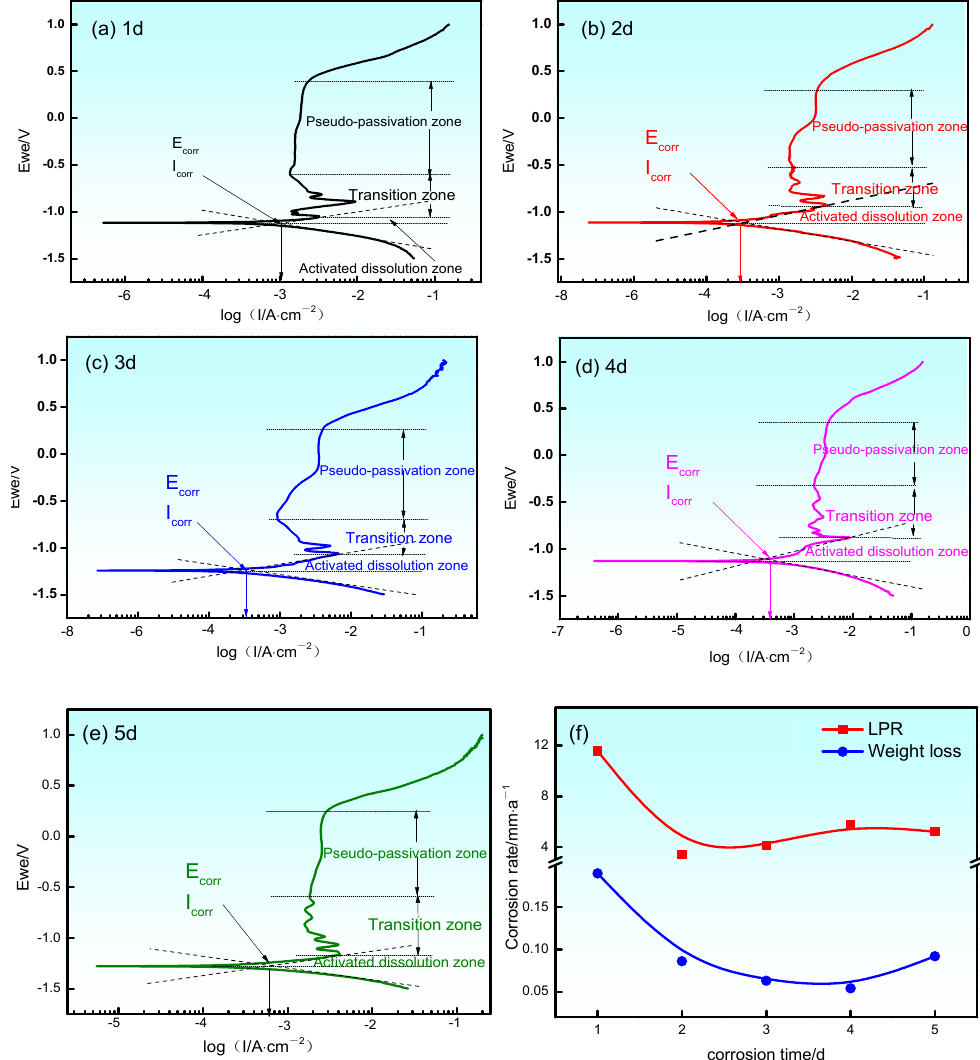
Figure 7. Polarization curves ( a – e ) for different corrosion times and a comparison with the weight-loss method ( f ) of Q235 steel.